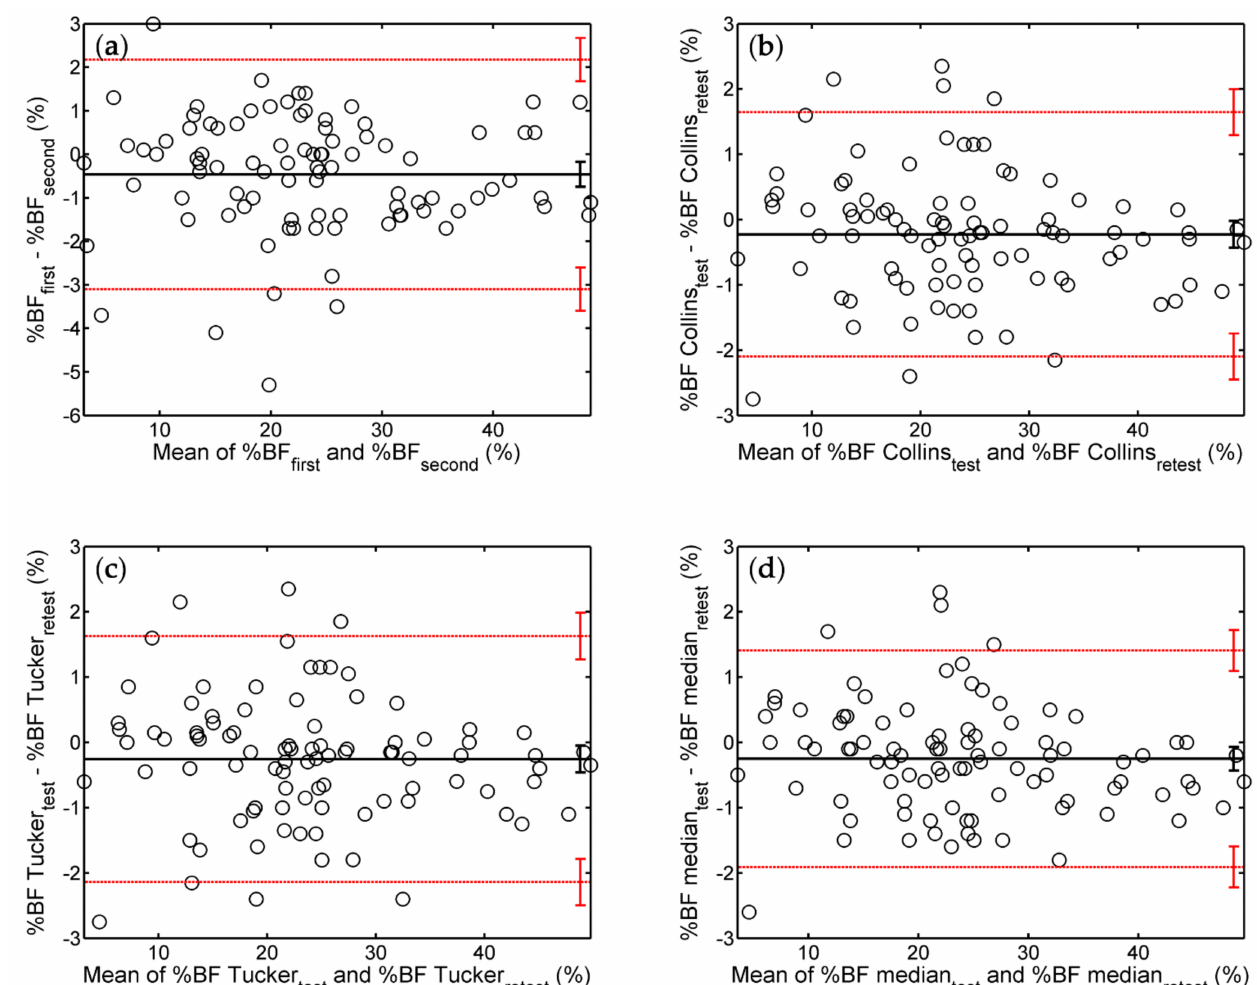
Figure 1. Bland–Altman (BA) analysis of the agreement between test and retest results of single ADP trials and three repeated trials protocols. Shown are plots of differences versus means of two assessments of %BF via ( a ) individual trials, ( b ) the Collins protocol, ( c ) the Tucker protocol, and ( d ) the median protocol. In each panel, the thick, solid, horizontal line depicts the bias (the mean value of the differences), whereas the red, thin, dotted, horizontal lines represent the 95% limits of agreement (bias ± standard deviation of the differences). Vertical error bars represent the 95% confidence intervals (95% CI) of the corresponding